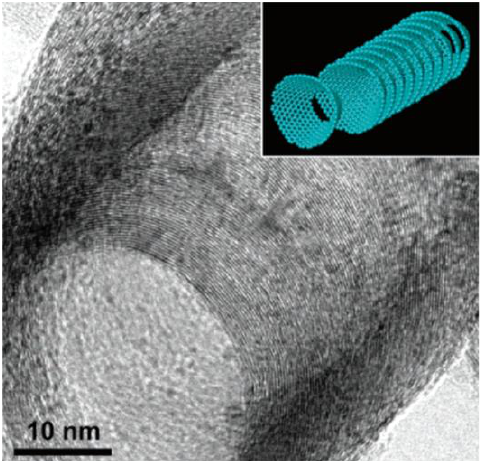
Figure 1. High resolution transmission electron microscope image of a milled stacked-cup carbon nanotube (SCCNT) taken at a tilted angle. Stacked cup morphology is very uniform for every cup. The inset demonstrates a schematic structural model. Reproduced from [49] with permission from American Chemical Society, 2019.